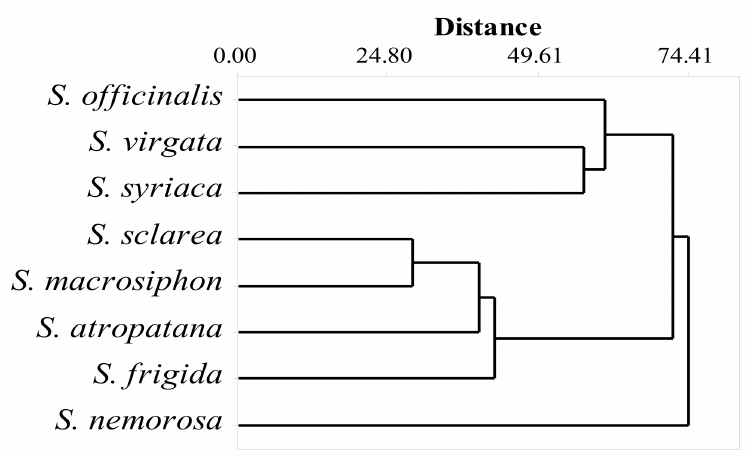
Figure 4. Dendrogram obtained by cluster analysis of the essential oil compounds for eight Salvia species (Ward